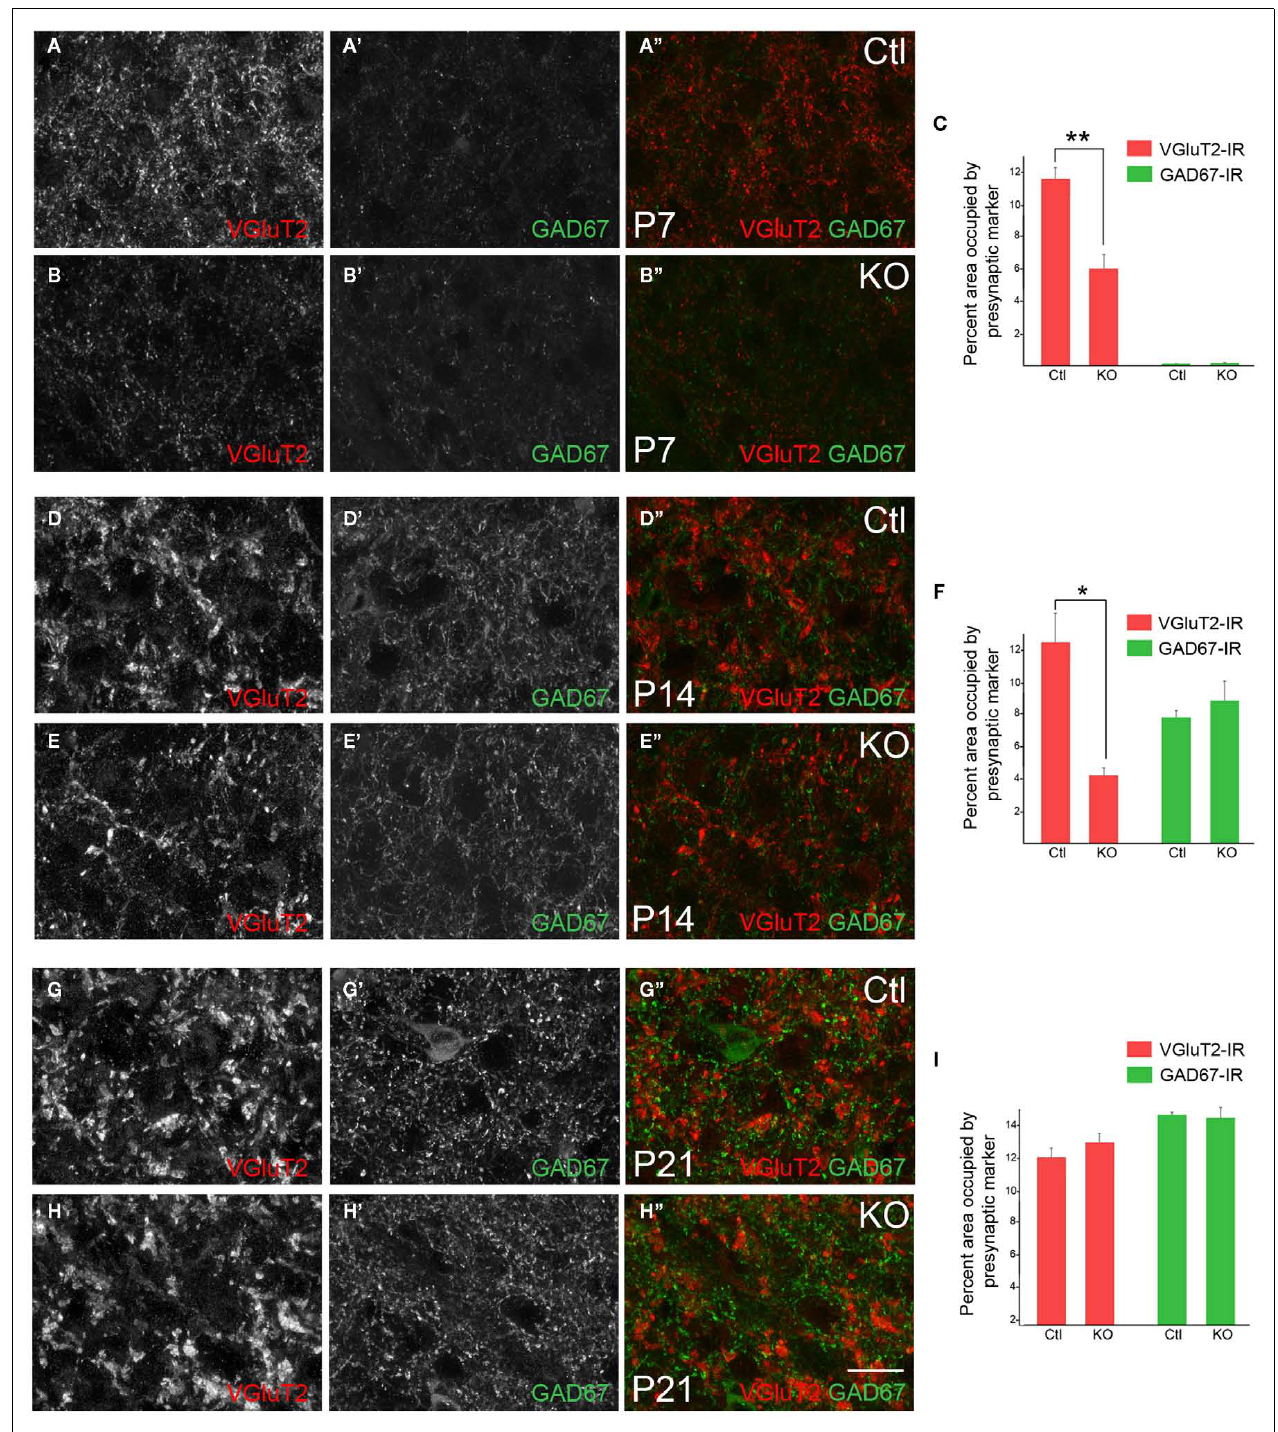
terminals appeared less mature and the area that mutant terminals occupied in each field of view was significantly lower than in controls (D–F) . By P21 no differences were observed inVGluT2–IHC in dLGN of mutants and controls (G–I) . At all ages GAD67-immunoreactivity (GAD67-IR) appeared similar in fgf22 − / − and control dLGN. For (C,F,I) data shown are ± SEM; n = 4 mice. *Differs from age-matched controls at p < 0.05 by Student’s t -test. **Differs from age-matched controls at p < 0.01 by Student’s t -test. Scale bar in (H) = 15 μ